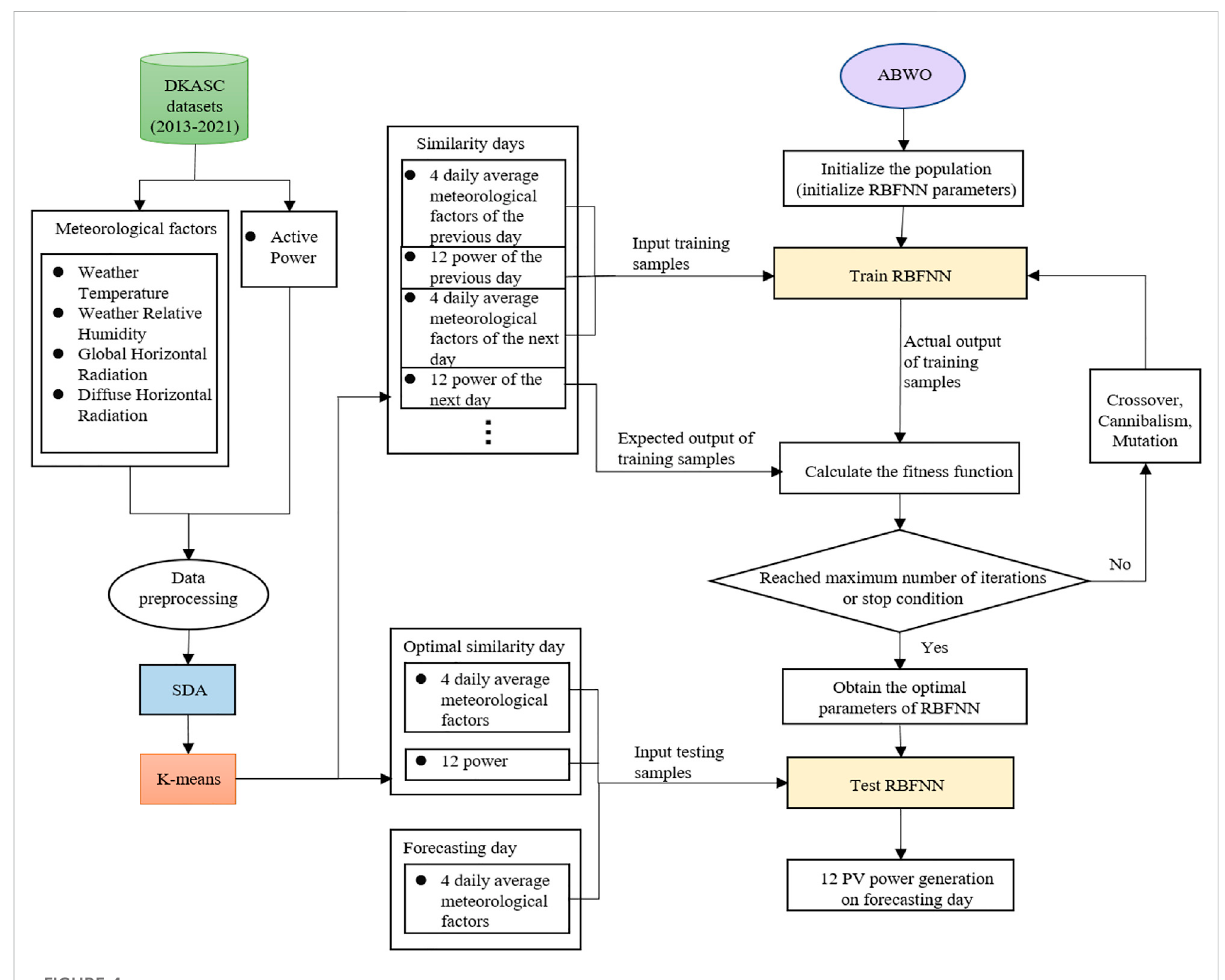
FIGURE 4 System architecture of the KM-SDA-ABWO-RBF